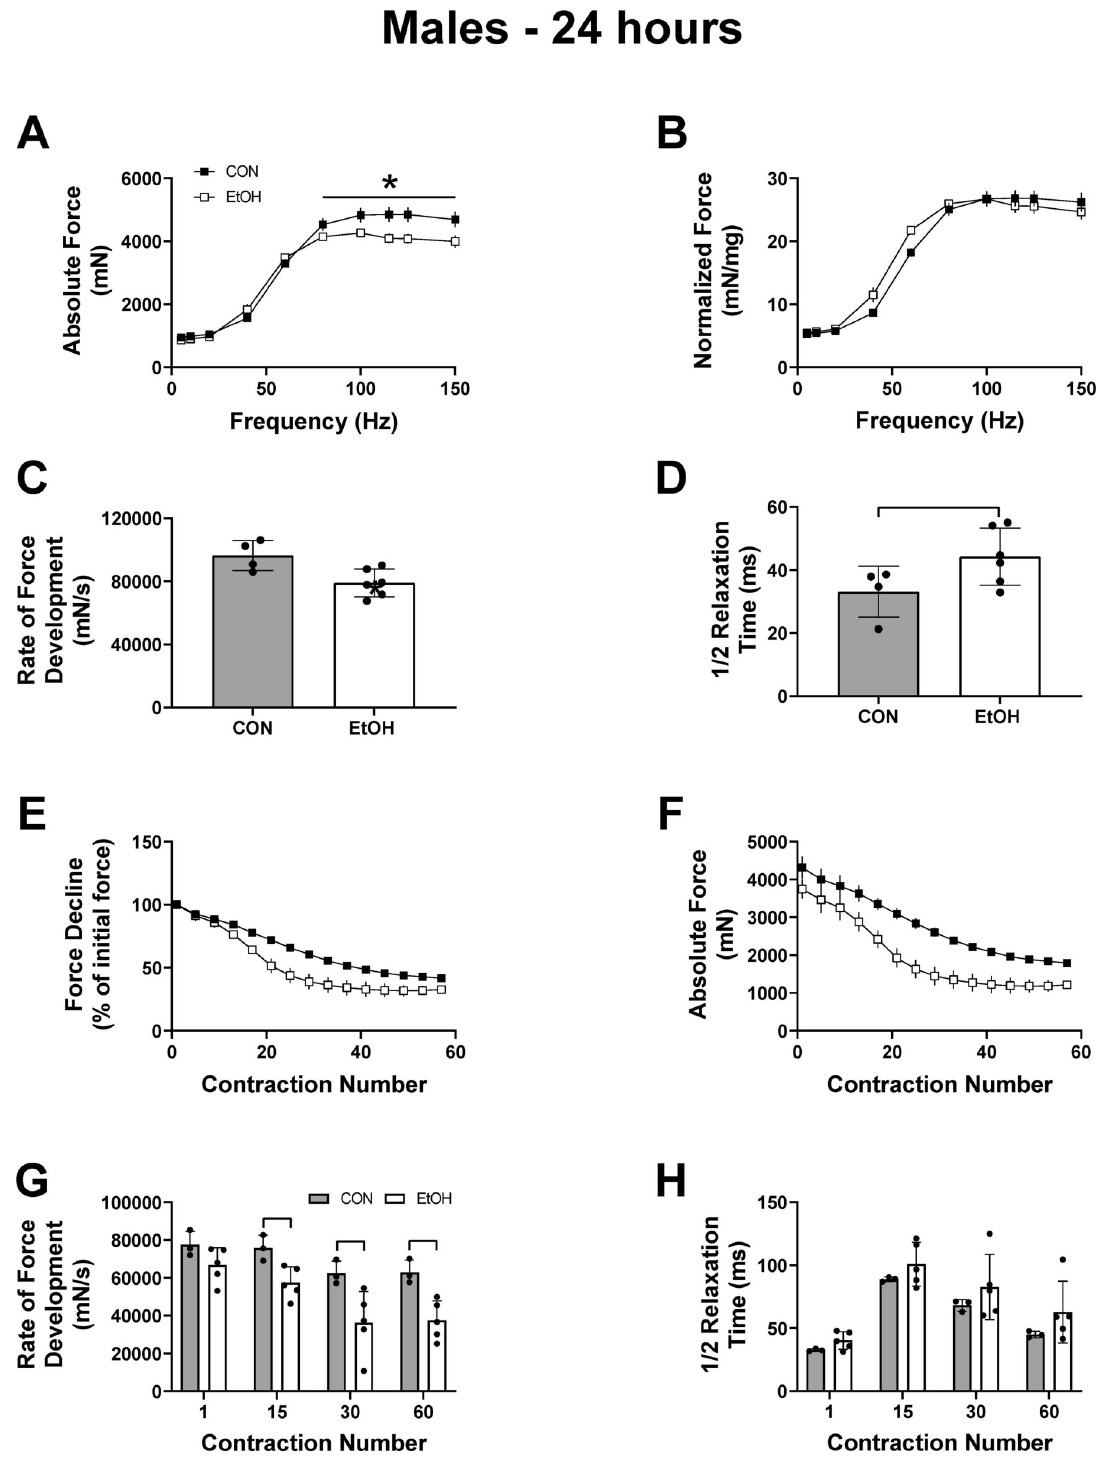
Fig 5. Partial recovery of muscle contractile properties and fatigue resistance in male mice 24 hours post alcohol intoxication. Outcomes of each contractile test at 24 hours post alcohol binge in male CON (n = 3–4) and EtOH (n = 5–6), mice. Panel A and B show absolute and normalized force over a range of frequencies, and Panel C and D show the rate of force development and ½ relaxation time at 125Hz. Panel E and F show the force decline either relative to the first stimulation (E) or in absolute terms (F). The rate of force development at a given contraction number during the fatigue protocol is shown in (G), with the corresponding ½ relaxation time